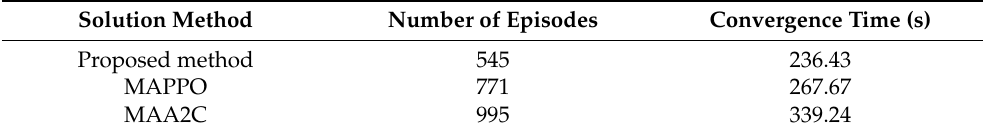
Table 5. Convergence comparison of different RL